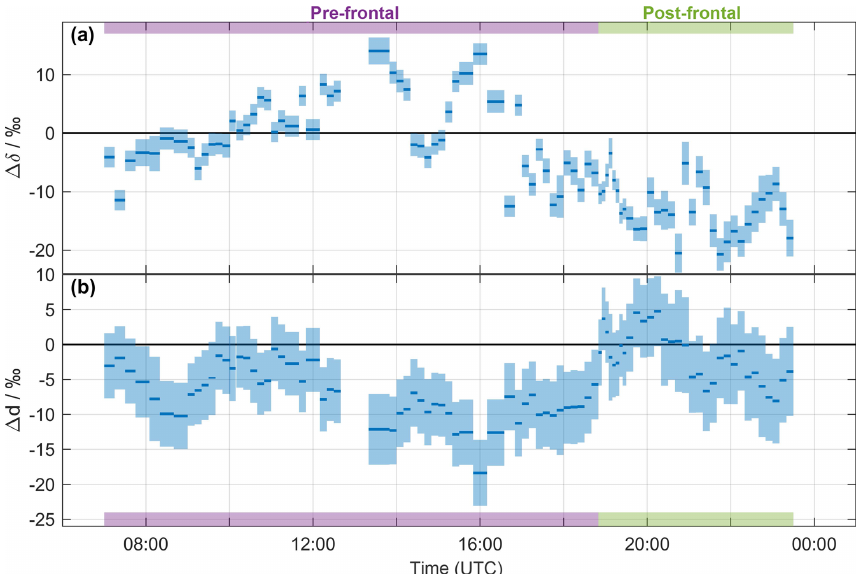
Figure 3. Time series of (a) (cid:49)δ and (b) (cid:49)d of the precipitation samples collected on 20 November 2015. The width of the blue bars denotes the period over which the rain samples were collected. The calibrated uncertainties are indicated by the shaded areas. Pre- and post-frontal periods are indicated with purple and green bars,